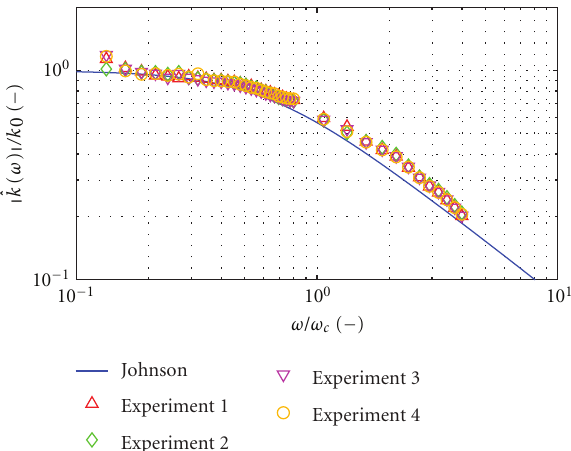
Figure 6: Phase value of the dynamic permeability. Theory of John- son et al. [59] versus measurements, using the parameters as shown in Table 1. Experiments 1–4 denote repeated experiments at di ff er- ent